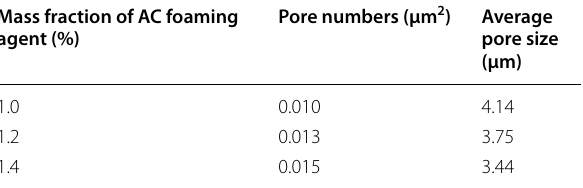
Table 5 Characteristics of surface pore of particles with different AC foaming agent content Mass fraction of AC foaming agent (%)